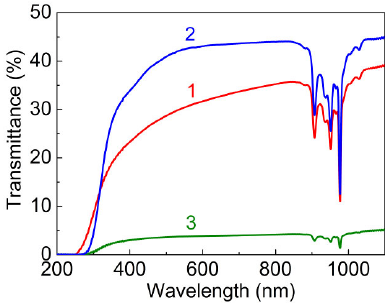
Fig. 6 In-line optical transmittance spectra of (Y 0.86 La 0.09 Yb 0.05 ) 2 O 3 ceramics, sintered at T = 1750 ℃ using Alpha-Micro (1), Alpha-Nano (2), and ITO-V (3) Y 2 O 3 powders.